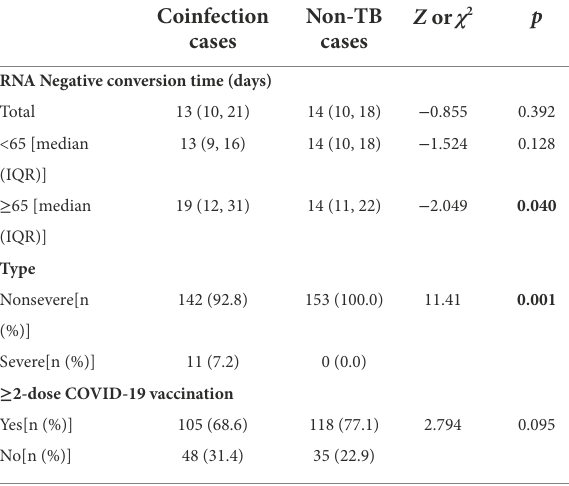
TABLE 4 Differences between COVID-19 and TB coinfection cases and non-TB COVID-19